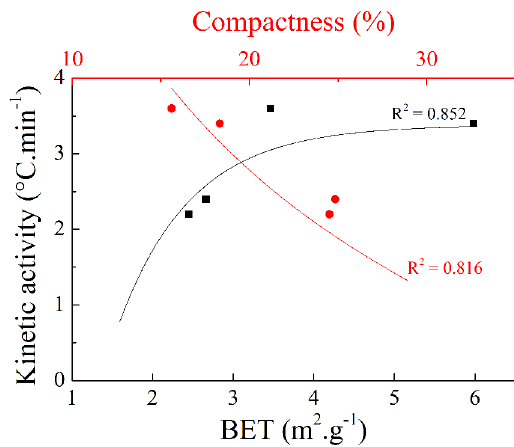
Figure 9. Relationship between kinetic activity, compactness, and specific surface area (BET) of plasters verified by X-ray tomography analysis that the size of the hemihydrate particles influences the temperature kinetics and the microstructure of the cured